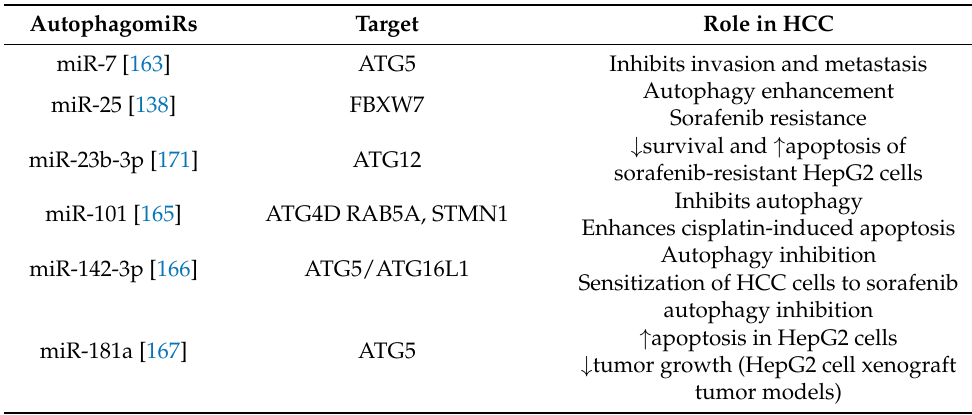
Table 6. The role of autophagomiRs in